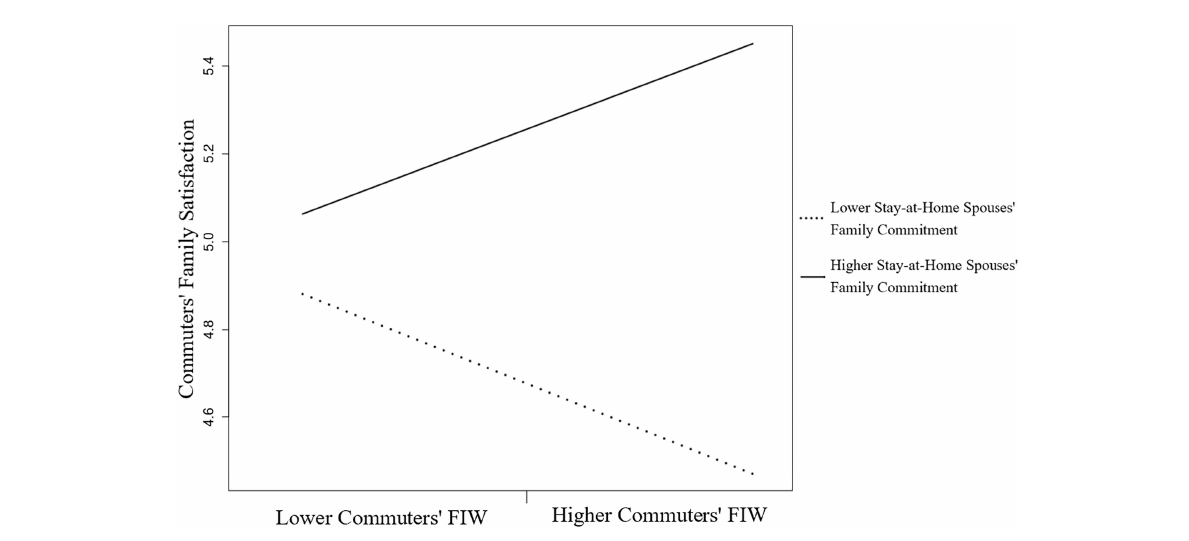
FIGURE4 The moderating effect of stay-at-home spouses’ family commitment of the FIW and family satisfaction relation for commuters.